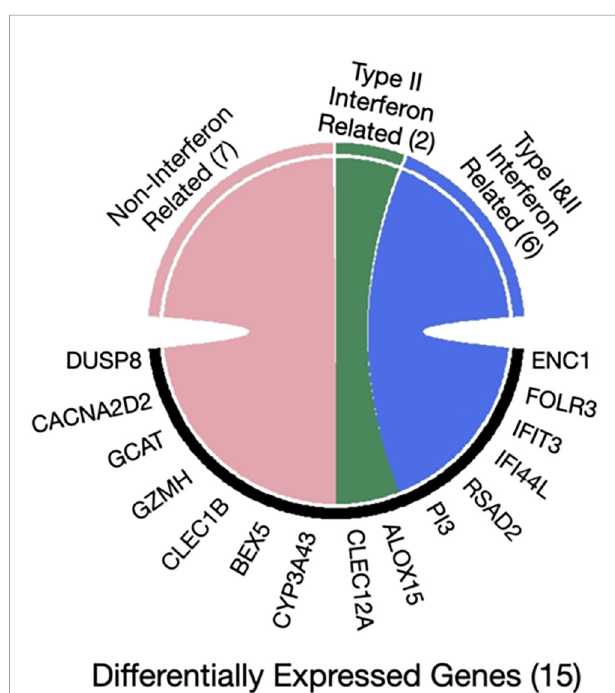
FIGURE 3 | Chord diagram of differentially expressed genes in seropositive healthy individuals with prior asymptomatic or clinical SARS-CoV-2 infection with respect to interferon activity. The 15 genes characterized as differentially expressed in those with prior asymptomatic relatively to those with clinical infection were queried in the Interferome database and 8/15 were found to be associated with interferon activity. Of those, 6 are regulated by both interferon type I and II (blue), while 2 genes only by type II (green) and none by type III; the 7 remaining genes are not regulated by interferons